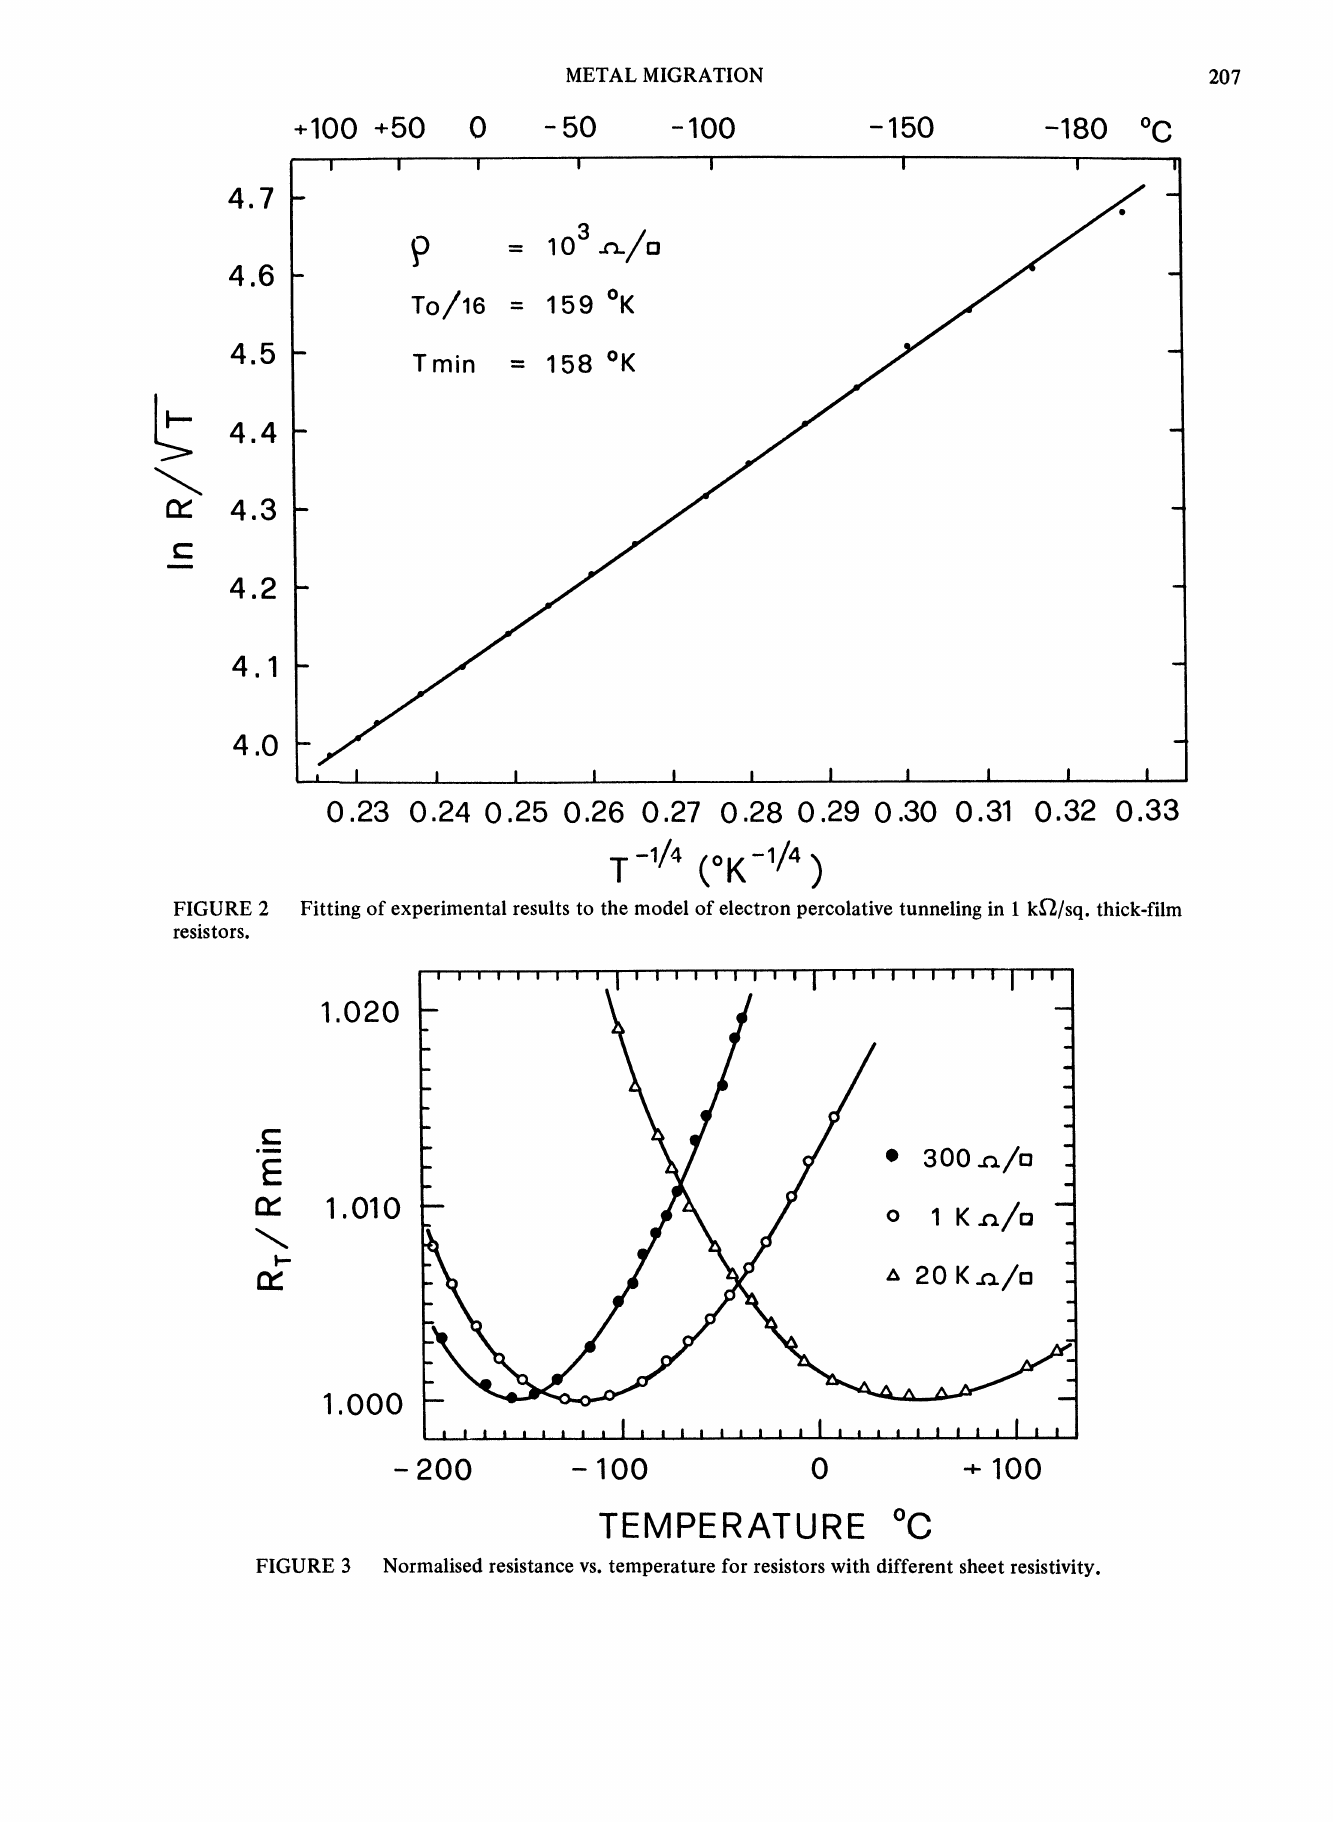
TEMPERATURE C FIGURE 3 Normalised resistance vs. temperature for resistors with different sheet